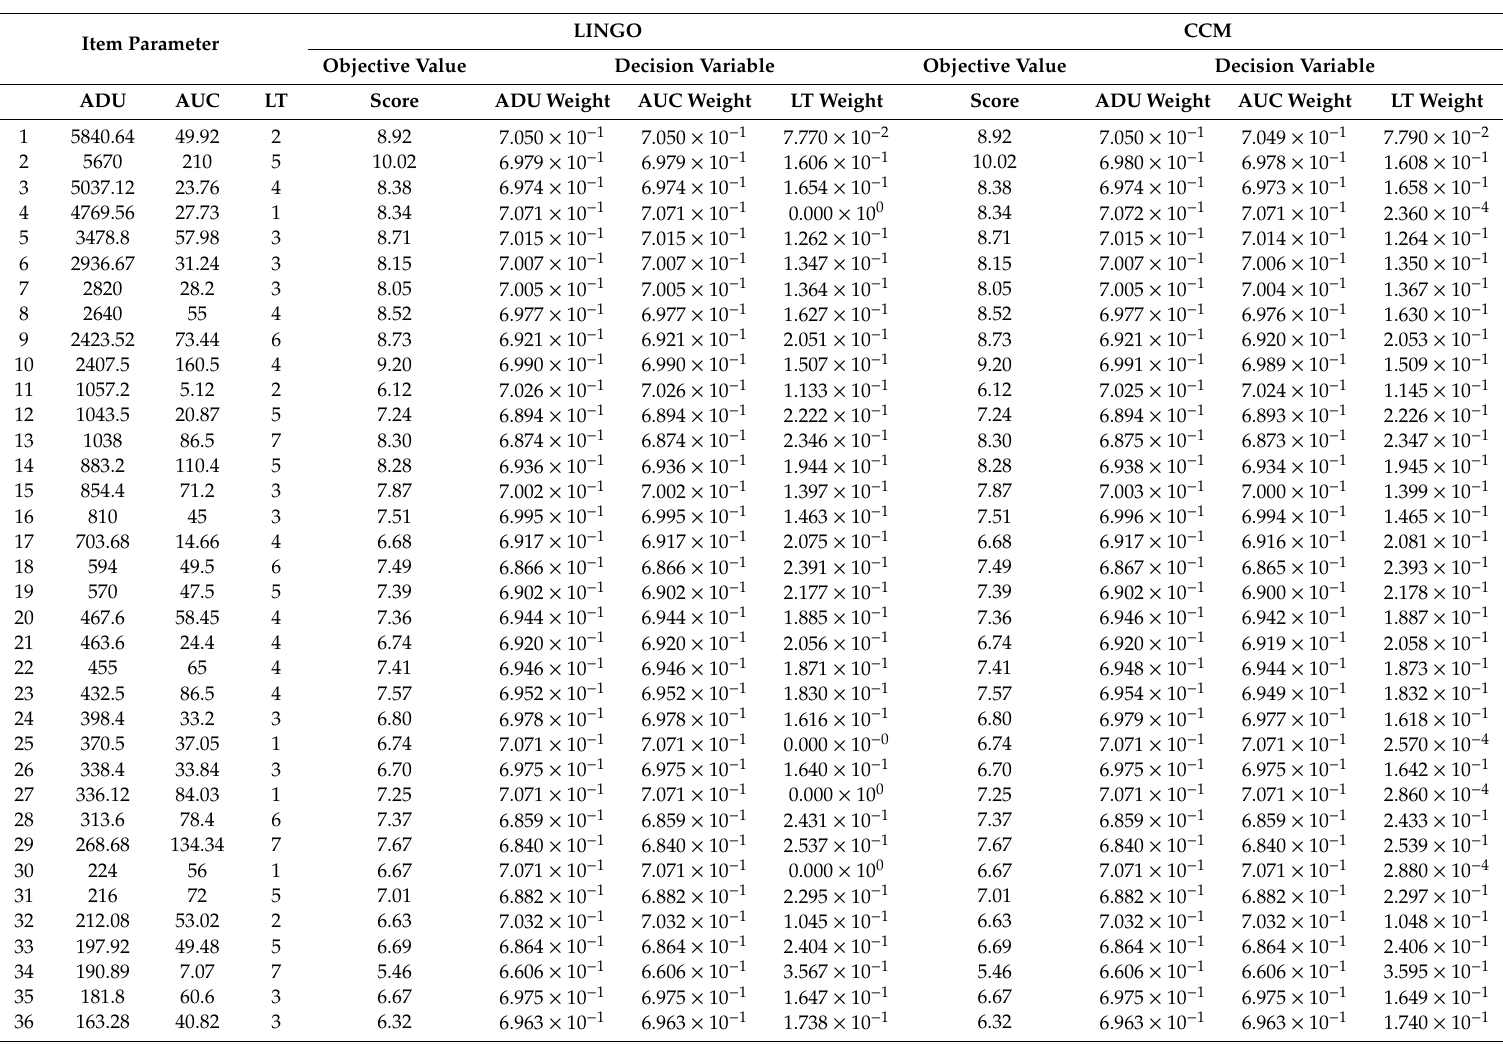
Table 1. Measures of inventory items, including their optimal scores and